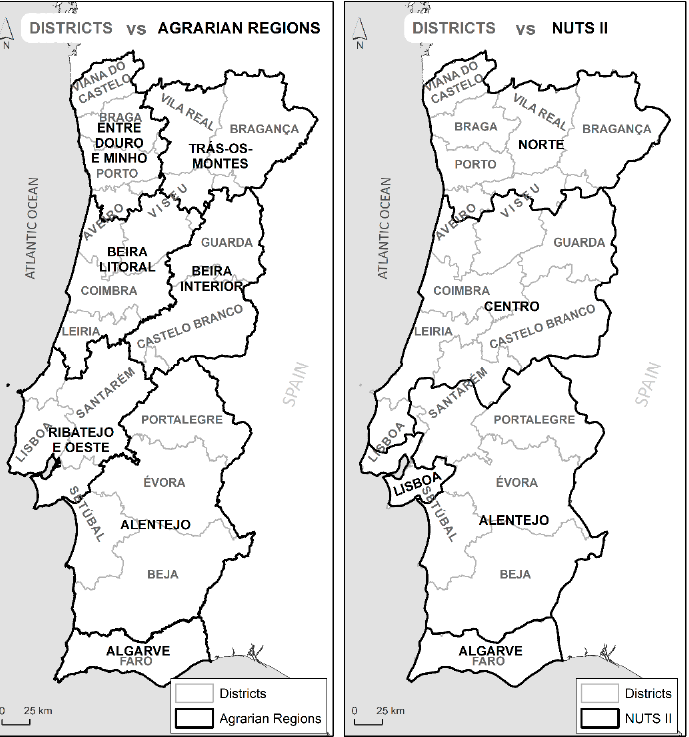
Figure 2. Differences between each administrative level (district vs. agrarian regions and district vs. NUTS II).